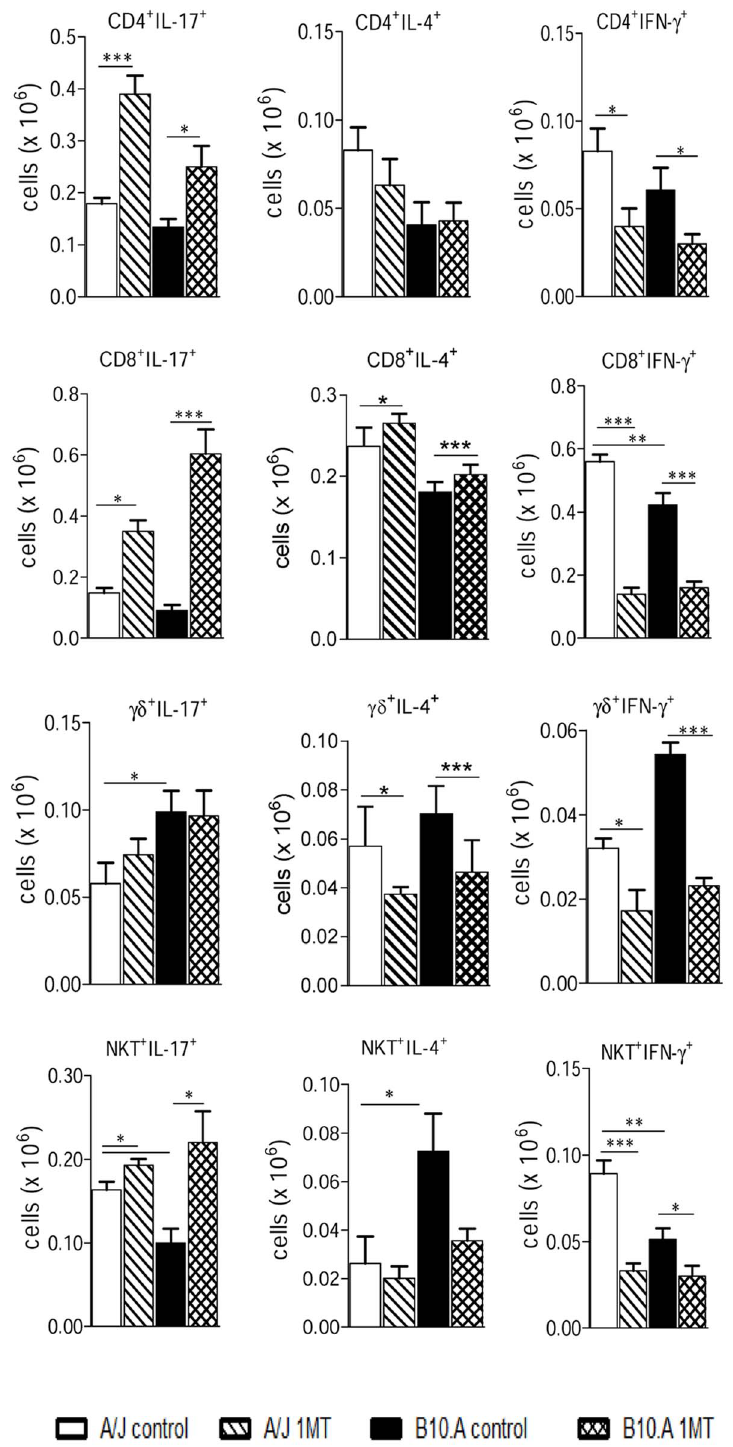
Figure 9. IDO blockade increases the presence of IL-17 + , but reduces the number of IFN- c + T cells in the lungs of A/J and B10.A mice. Lymphocytes from lung infiltrating leukocytes (LIL) obtained from groups of 5–6 mice were gated based on forward/side scatters analysis. Gated cells were assessed for CD4 + , CD8 + , cd + and NKT + markers using labeled antibodies. The presence of IL-17 + , IFN- c + and IL-4 + T cells in the LIL was determined by intracellular cytokine staining at week 2 after infection. Lung cells were stimulated in vitro with PMA/ionomycin for 6 h, the last 4 h in the presence of brefeldin A, and subjected to intracellular staining for IL-17, IL-4 and IFN- c . The results are representative of three experiments with equivalent results (* p , 0.05, ** p , 0.01 and *** p , 0.001).